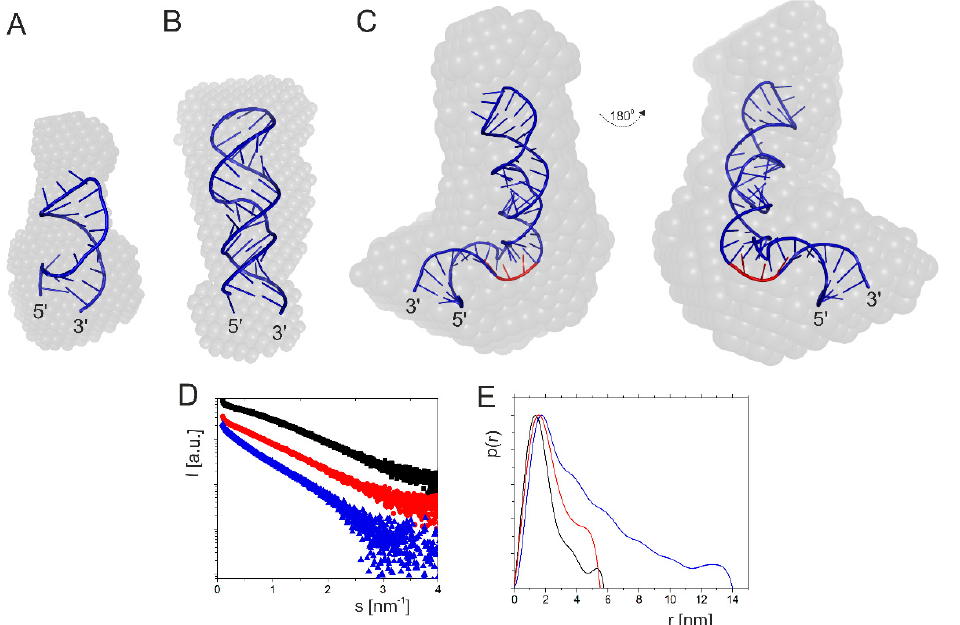
Figure 2. Structural analysis of mRNA fragments: RNA-30/-10 ( A ), RNA-38/-2 ( B ) and RNA-51/9 ( C ). Panels A, B and C present SAXS-derived ab initio envelopes obtained using DAMMIF algorithm superimposed with tertiary structures generated by RNAComposer. The AUG1 initiation codon is marked in red. ( D ) Experimental SAXS curves in the range of vector s from 0.0088 nm − 1 to 4 nm − 1 . ( E ) Corresponding pair distance distribution function shows the elongated shapes of analyzed fragments of p53 mRNA; these shapes are typical of polyanions in a polar solution: RNA-30/-10—black, RNA-38/-2—red, RNA-51/9—blue. Table 1. SAXS data collection and structural parameters for RNA -30/-10, -38/-2, -51/9, 47/81, 89/140, 47/140 and -122/201.